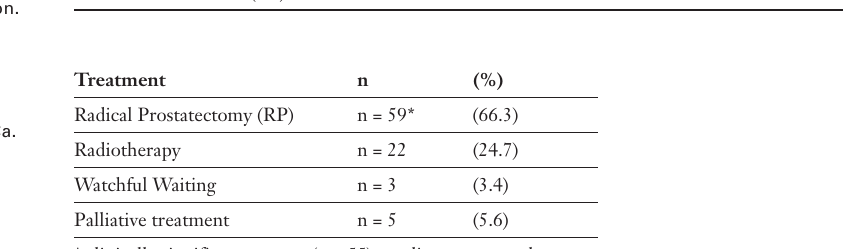
The number of prostate biopsies, prostate cancer de- tection rates and per- cent of pathologically organ confined can- cers (pT2) according to PSA distribution.